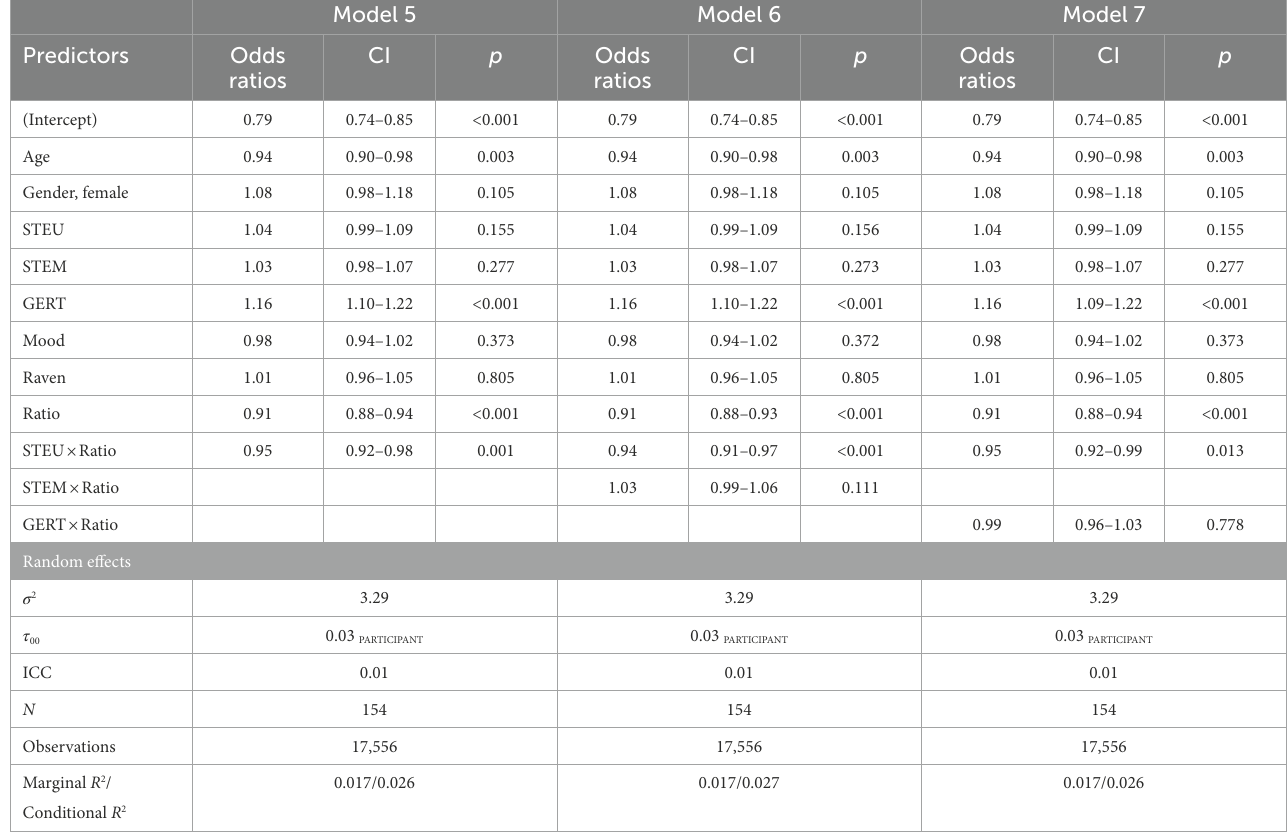
Odds ratios correspond to the exponential function of the regression coefficient from the logistic regression. STEU, situational test of emotion understanding; STEM, situational test of emotion management; GERT, Geneva emotion recognition